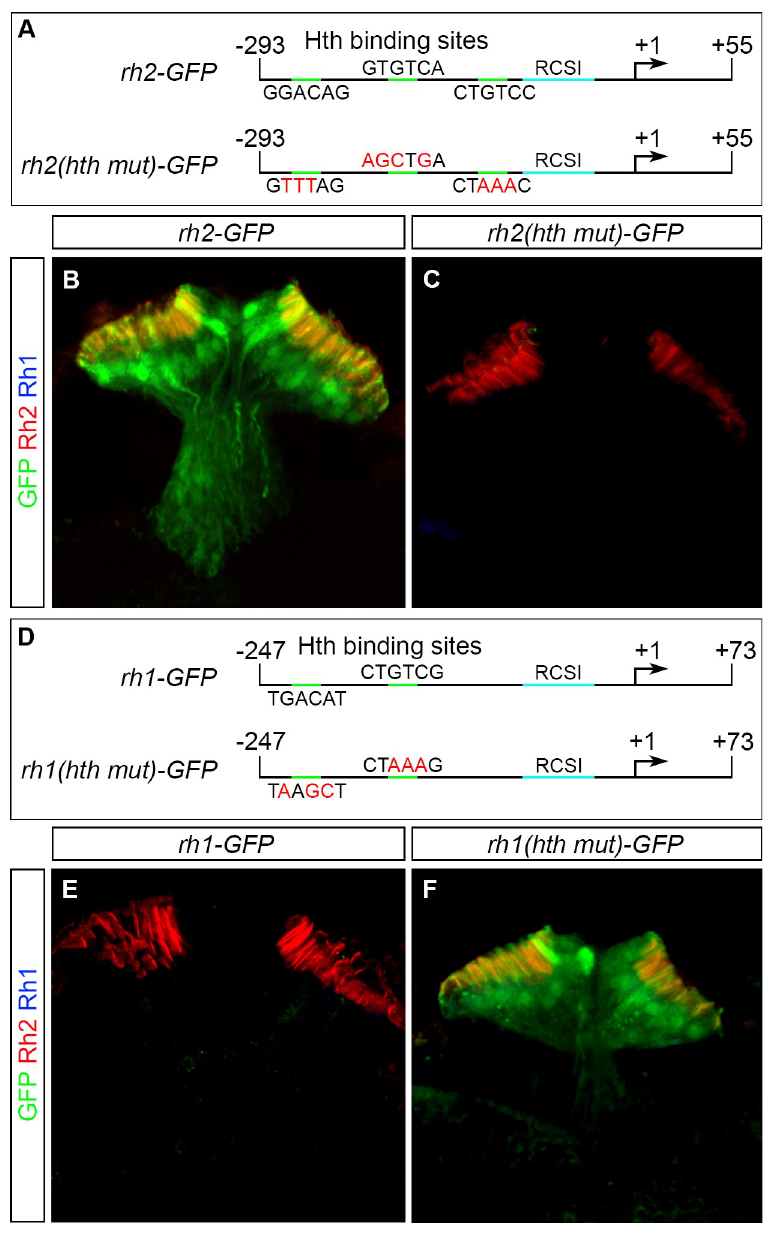
Fig 3. Expression of rh1 and rh2 reporter constructs in ocelli. (A) Schematic representation of the rh2 minimal promoter used for making GFP reporter constructs ranging from positions -293 to +55 of the transcription start (+1, arrow). The wildtype promoter ( rh2-GFP ; in the top) contains three potential Hth binding sites (green) with their corresponding sequences shown. In the hth mutant promoter ( rh2(hth mut)-GFP ; in the bottom), the mutated sequences are shown with altered residues depicted in red. (B, C) Expression of the wildtype rh2-GFP and mutant rh2 (hth mut)-GFP reporter lines (green) in ocelli stained with antibodies against GFP (green), Rh2 (red) and Rh1 (blue). Wildtype rh2-GFP (marked by anti-GFP) is expressed in PRs of ocelli (marked by anti-Rh2) staining the entire rhabdomeres (B) whereas the mutant rh2(hth-mut)-GFP (marked by anti-GFP) is not expressed in ocelli (C). (D) Schematic representation of the rh1 minimal promoter used for making the GFP reporter constructs ranging from positions -247 to +73 of the transcription start (+1, arrow). The wildtype promoter (top) contains two potential Hth binding sites (green; with its corresponding sequence shown). In the hth mutant promoter (bottom), the mutated sequences are shown with the altered residues depicted in red. (E, F) Expression of the wildtype rh1-GFP and mutant rh1(hth mut)-GFP reporter lines in ocelli stained with antibodies against GFP (green) Rh2 (red) and Rh1 (blue). (E) Like Rh1, the rh1-GFP reporter is not expressed in the PRs of ocelli expressing only Rh2. (F) The mutant rh1(hth-mut)- GFP reporter line is expressed in PRs of